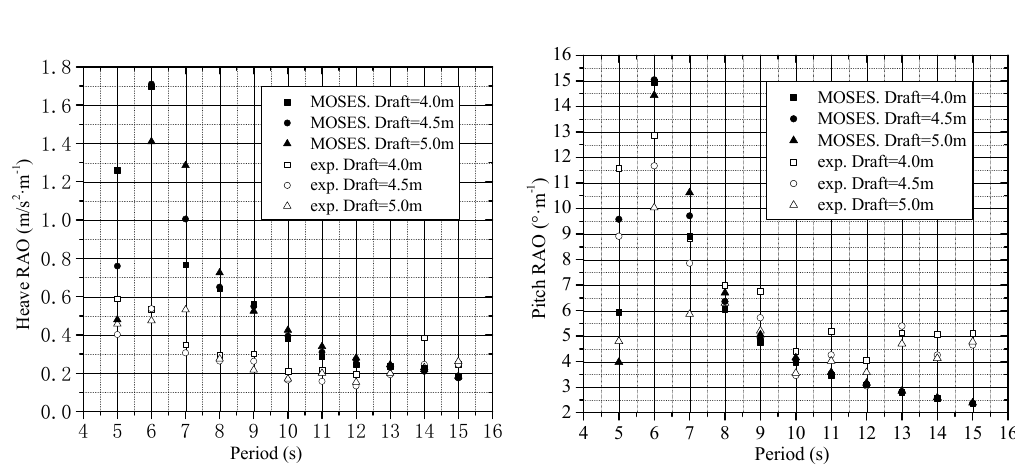
Figure 12. Experimental and simulated response amplitude operators (RAOs) for drafts of three di ff erent heights: ( a ) heave RAO and ( b ) pitch